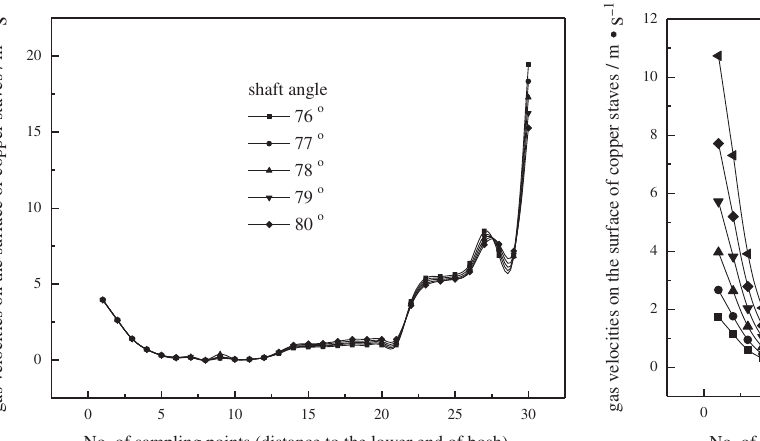
Figure 7: The velocities of the gas flow on the surface of the cooling stave under different conditions of variational equivalent Bosh